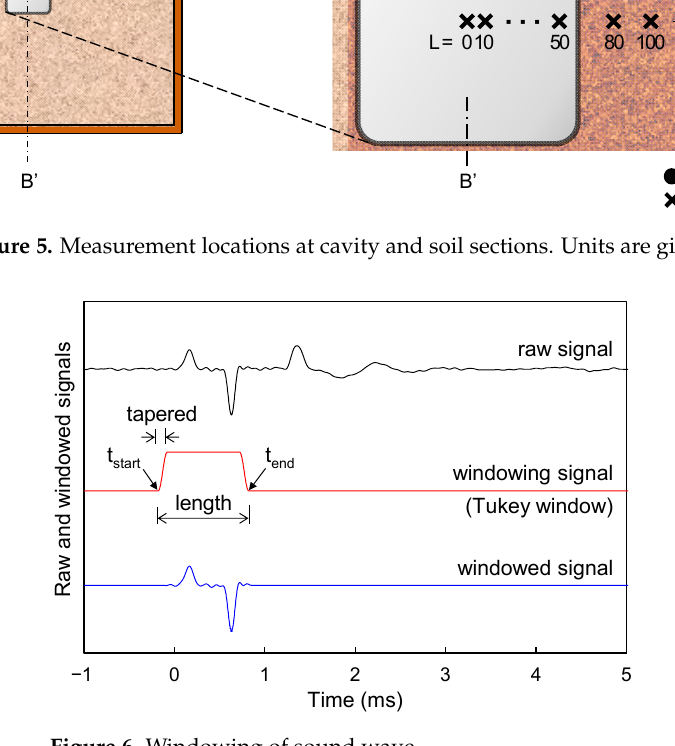
Figure 6. Windowing of sound wave. The raw sound waves at all measurement locations of the two acrylic plates with different thicknesses (T = 8 and 15 mm) are shown in Figure 7a,b. In addition, the windowed normalized sound waves by the hammer impact, i.e., the ratio of the windowed raw sound waves to the peak amplitude of the load signal due to hammer impact, are plotted in Figure 7c,d. According to Figure 7, the maximum peak-to-peak amplitude of the first wave crest and trough appeared at the measurement location of L = 0 mm, for both acrylic plates, and gradually decreased as the measurement location became farther from the cavity center. Thus, the peak-to-peak amplitudes of the first wave crest and trough at the cavity section are larger than that at the soil